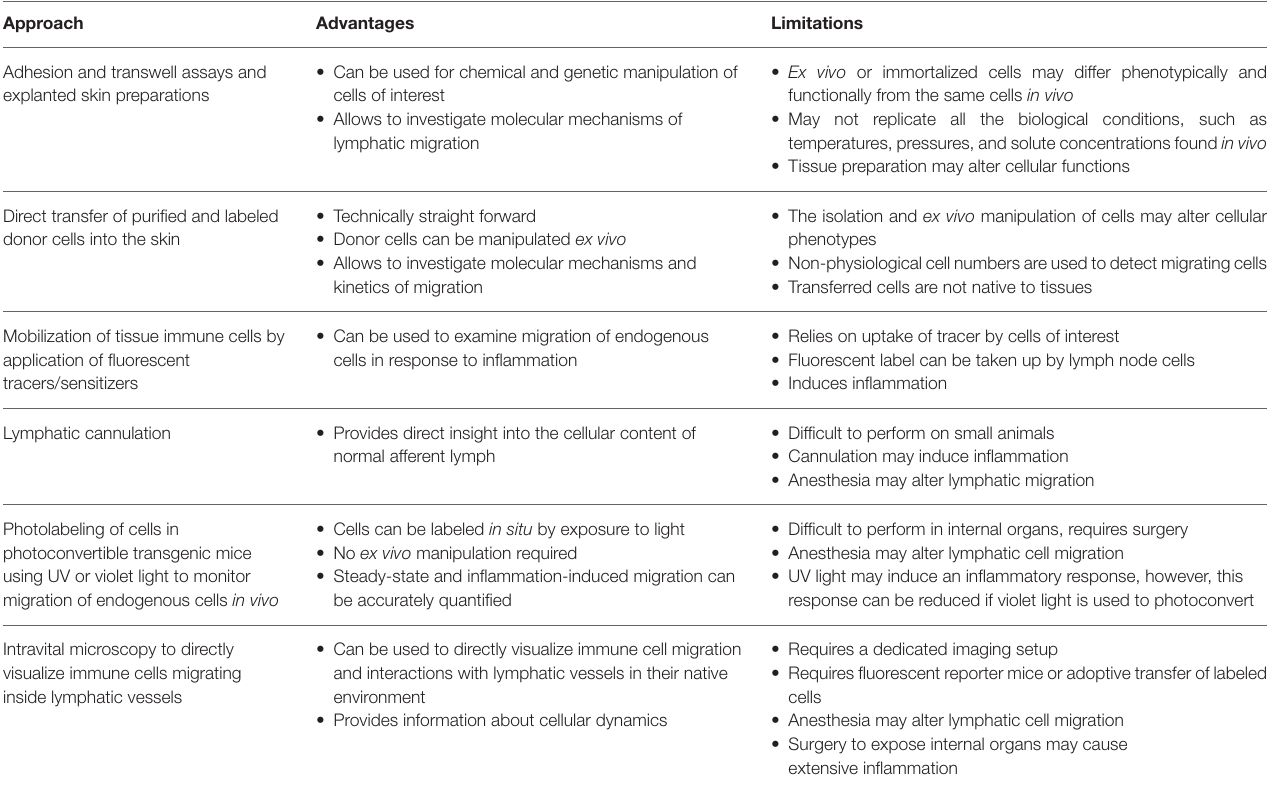
TABLE 1 | Methods for investigating immune cell migration via afferent lymphatic vessels.